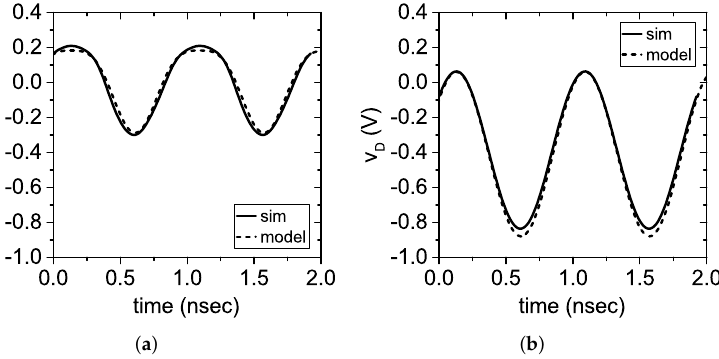
Figure 4. Diode voltage v D in time domain at P in = − 10 dBm: comparison between simulation and theoretical model ( a ) with the MOSFET switch closed (on) and ( b ) with the MOSFET switch open